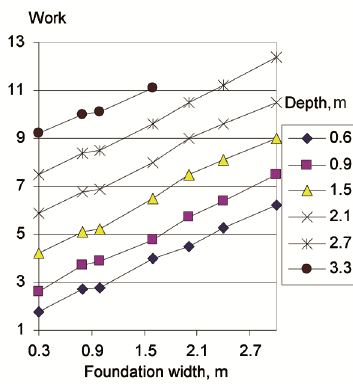
Fig. 3. The relative cost of a strip foundation (typical assembled)